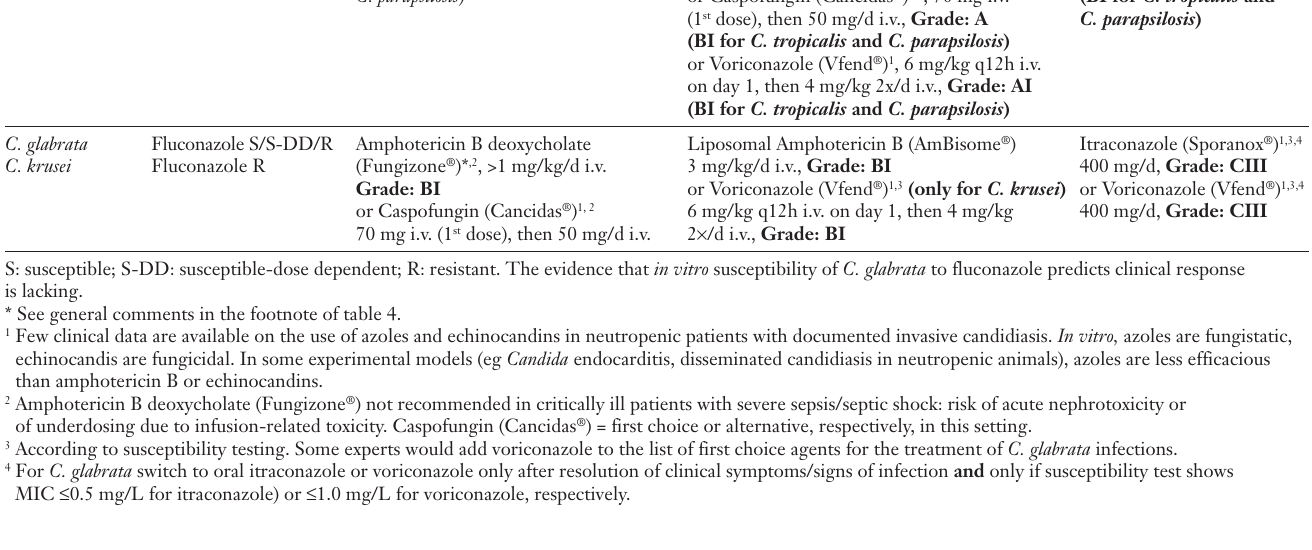
Grade: AI (BI for C. tropicalis and and C. parapsilosis